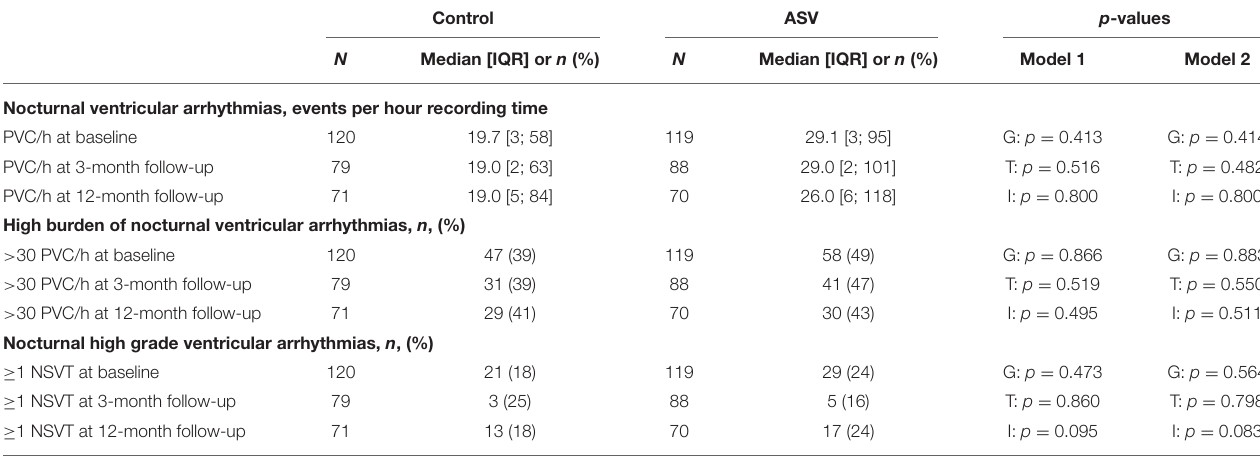
TABLE 3 | Nocturnal ventricular arrhythmias at baseline, and 3- and 12-month follow-up. Control ASV p -values N Median [IQR] or n (%) N Median [IQR] or n (%) Model 1 Model